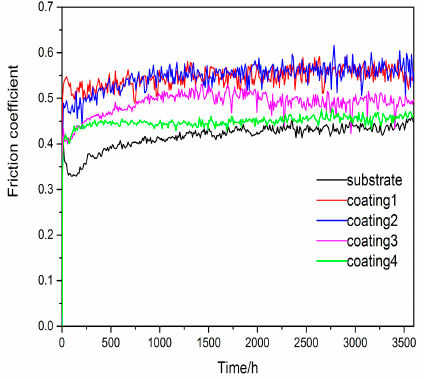
Figure 9. Friction coefficients of the substrate and laser cladding coatings at temperature.